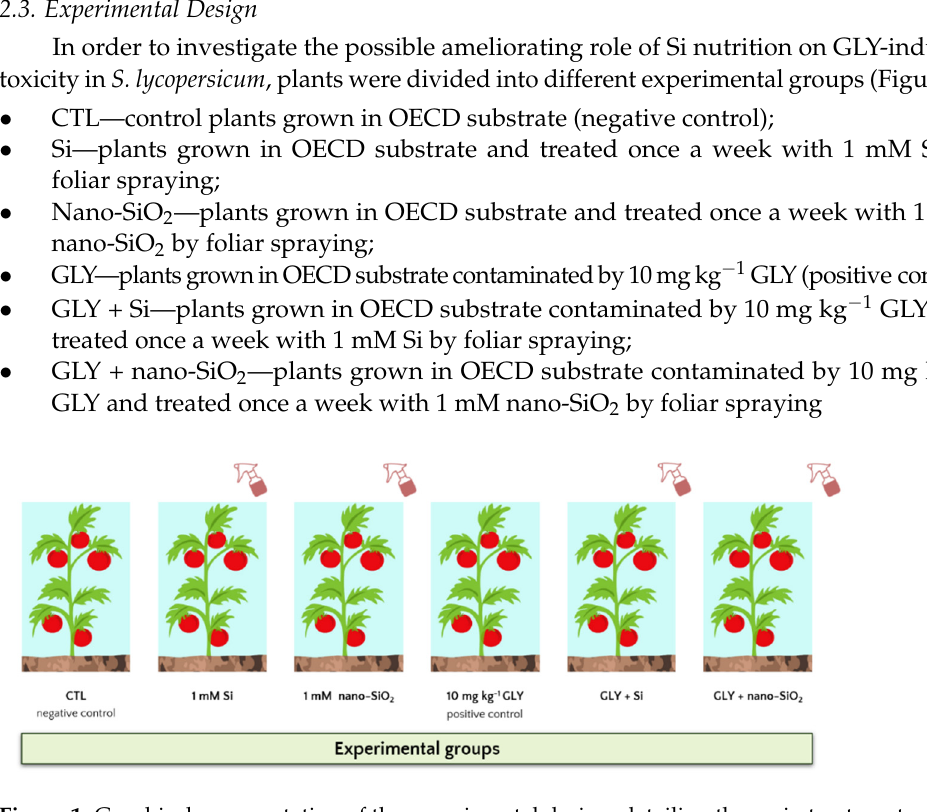
Figure 1. Graphical representation of the experimental design, detailing the main treatments.